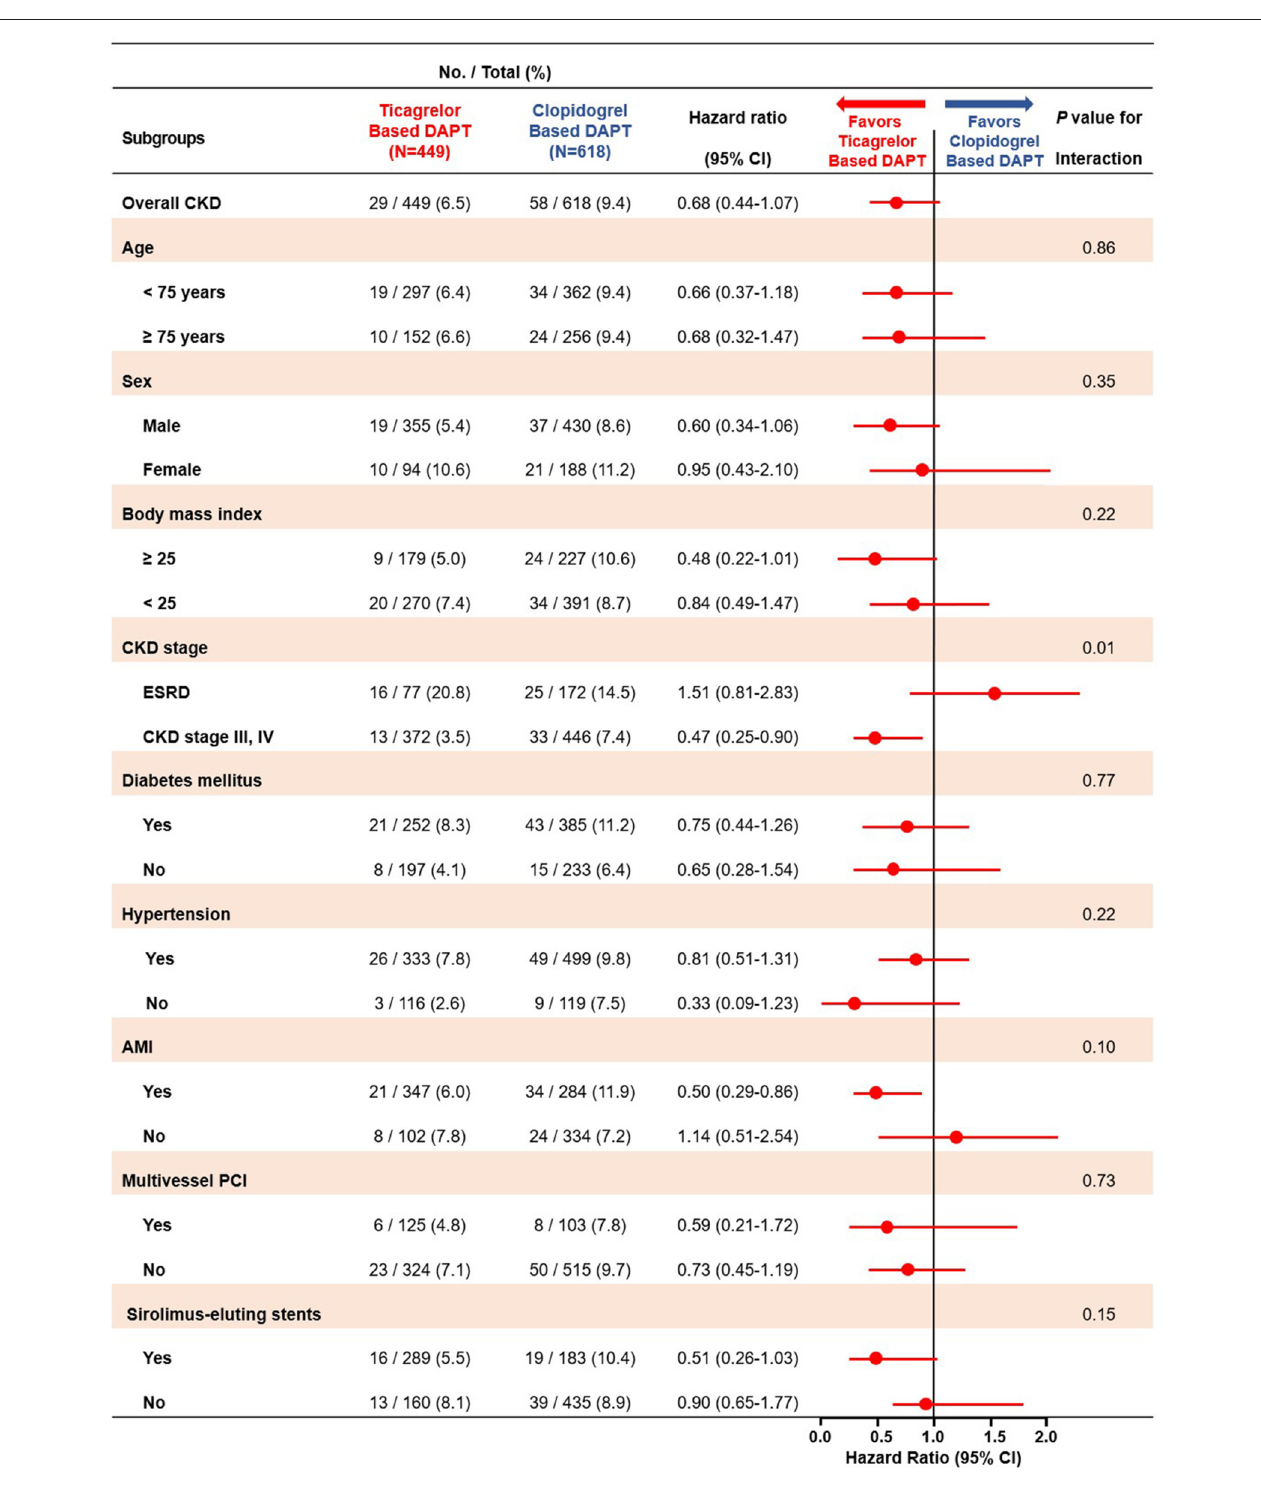
FIGURE 5 | Subgroup analyses of major adverse cardiac and cerebrovascular events between the ticagrelor- and clopidogrel-based DAPT groups. MACCE, Major Adverse Cardiac and Cerebrovascular Event; DAPT, Dual Anti Platelet Therapy; CKD, Chronic Kidney Disease; ESRD, End Stage Renal Disease; AMI, Acute Myocardial Infarction; PCI, Percutaneous Coronary